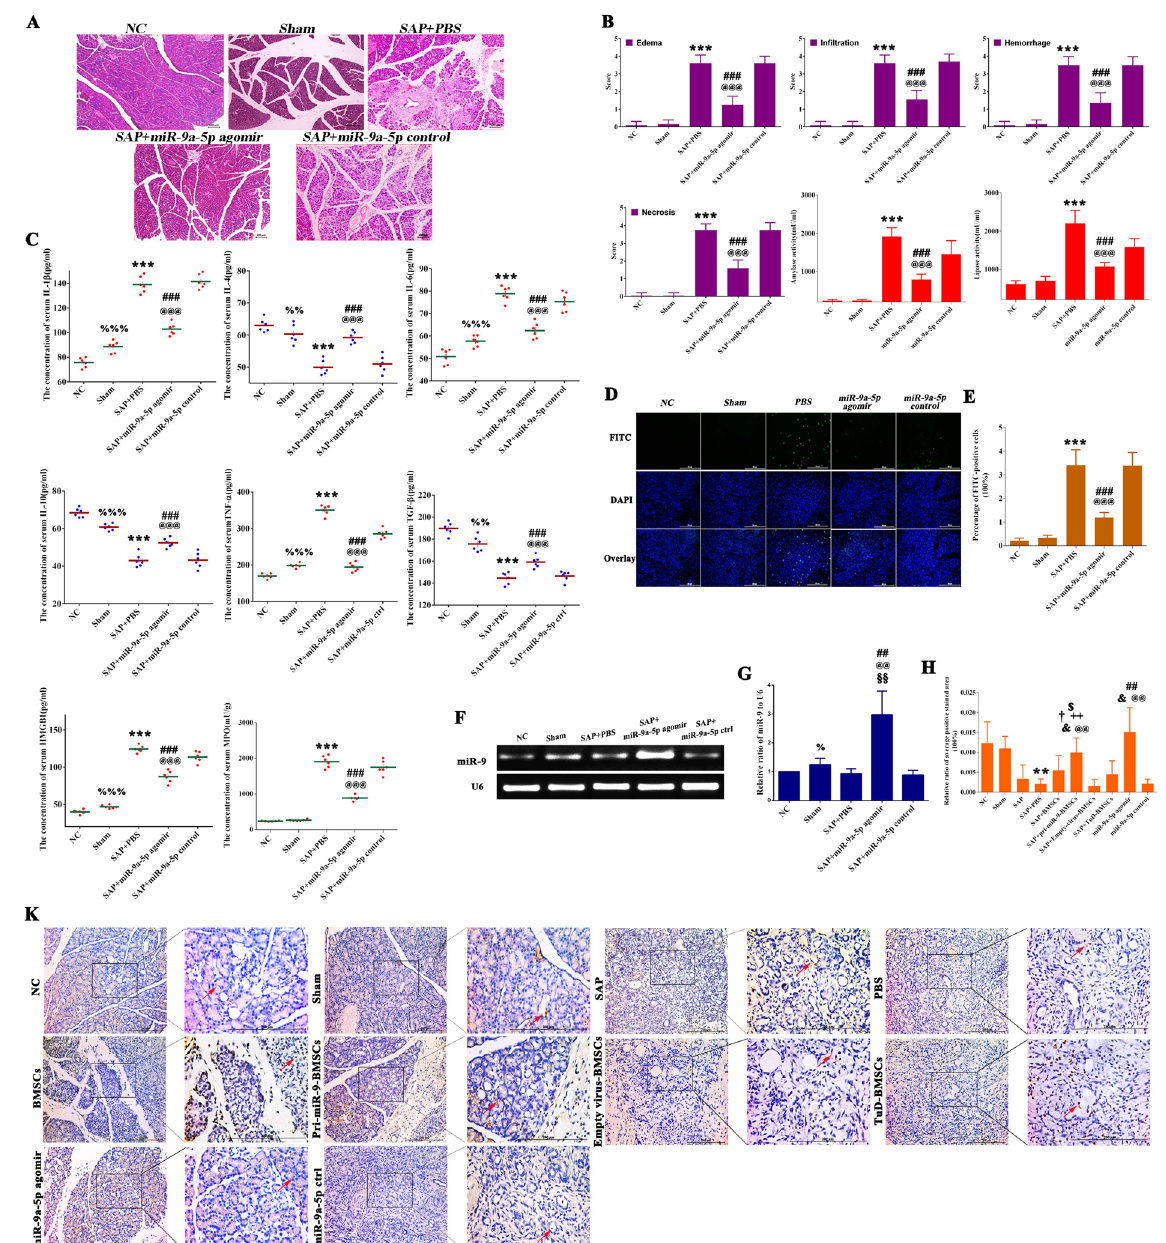
Figure 2. miR-9 could alleviate SAP. (A,B,C) miR-9a-5p agomir could significantly reduce the pancreatic edema, infiltration, hemorrhage and necrosis, the release of serum amylase, lipase and pro-inflammatory cytokines (IL-1 β , IL-6, TNF- α , HMBG1, and MPO) and elevate the levels of anti-inflammatory cytokines (IL- 4, IL-10, and TGF- β ), compared with SAP + PBS or miR-9a-5p control groups. (D,E) The cell apoptosis was significantly decreased by miR-9a-5p agomir, compared with SAP + PBS or miR-9a-5p control groups. (F,G) The expression of miR-9 in damaged pancreatic tissues was significantly up-regulated by miR-9a-5p agomir, compared with SAP + PBS or miR-9a-5p control groups. Data are shown as mean ± SD for at least 3 separate experiments. % P < 0.05, %% P < 0.01, §§ p < 0.01 and %%% P < 0.001, compared with NC, *** p < 0.001, compared with NC, @@ p < 0.01 and @@@ p < 0.001, compared with SAP + PBS group, ## p < 0.01 and ### p < 0.001, compared with miR-9a-5p control group by using two-tailed t test. (H,K) The results of in-situ hybridization showed that the expressions of miR-9 in damaged pancreas were significantly increased by pri-miR-9-BMSCs or miR-9a-5p agomir, compared with SAP, SAP + PBS, BMSCs, TuD-BMSCs, or miR-9a-5p control groups. Data are shown as mean ± SD for at least 3 separate experiments. ** p < 0.01, compared with NC, & p < 0.05, compared with SAP, @@ p < 0.01, compared with SAP + PBS, † p < 0.05, compared with BMSCs, ++ p < 0.01, compared with Empty virus-BMSCs, $ p < 0.05, compared with TuD-BMSCs, ## p < 0.01, compared with miR-9a-5p control by using two tailed t